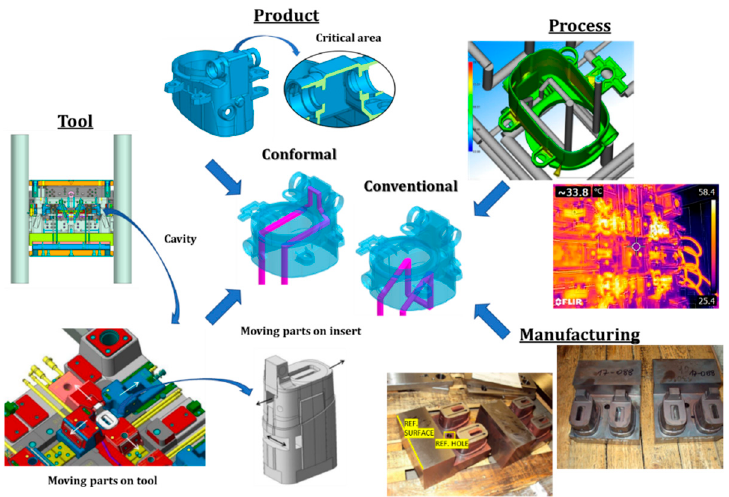
Figure 1. Challenges in selecting the cooling concept for injection molding.